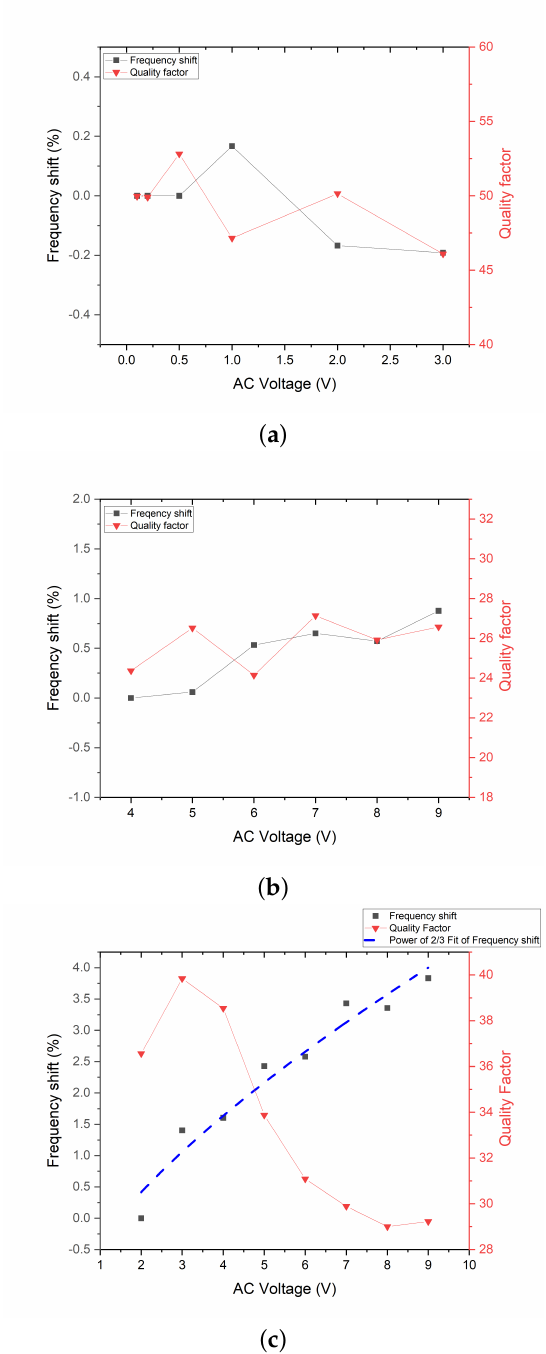
Figure 5. The frequency shift and quality factor of graphene/PMMA resonator under ( a ) mechanical actuation ( b ) electro-static actuation; ( c ) electro-thermal